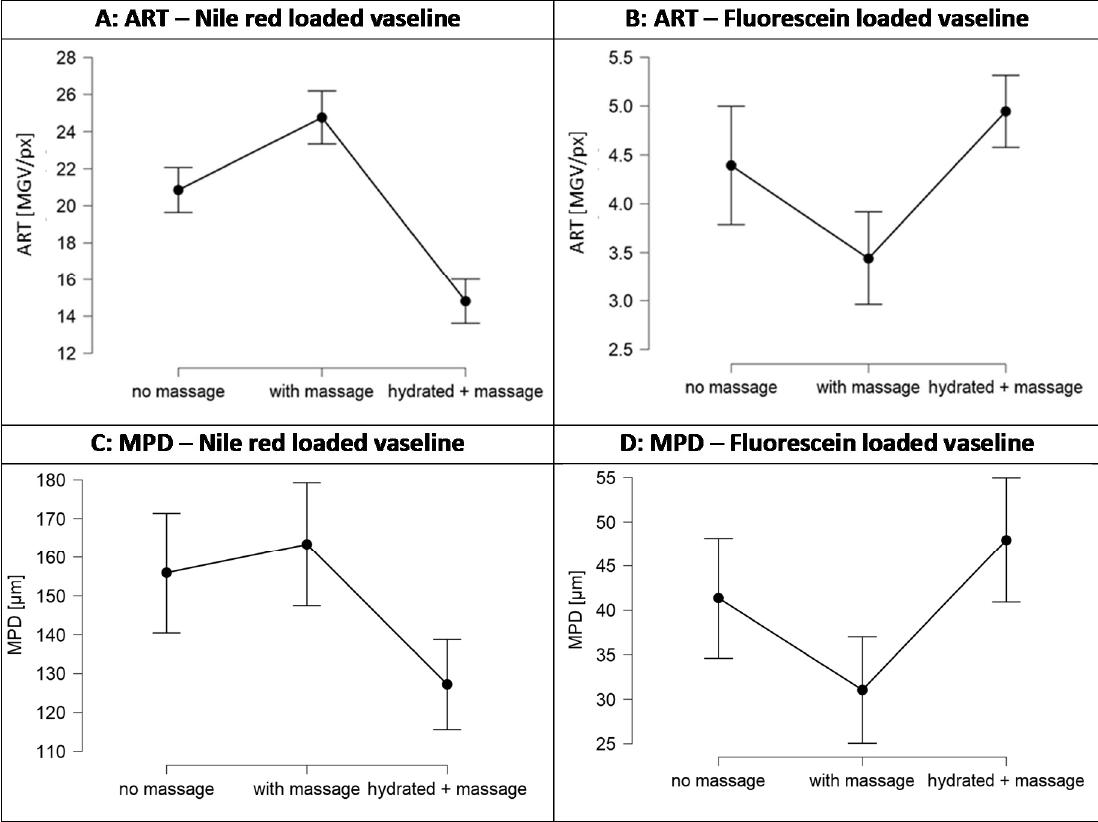
Figure 12. Comparison of influence of massage and skin hydration on the penetration efficacy of Nile red (( left ), surrogate for hydrophobic AI—cf. Figure 6) and fluorescein (( right ), surrogate for hydrophilic AI). Explanations cf. text.